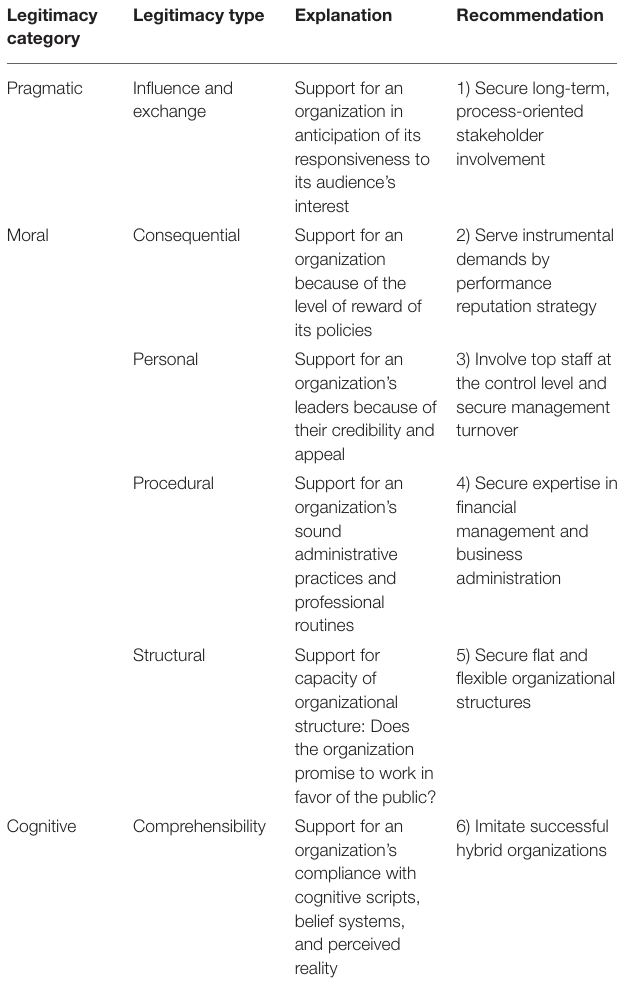
TABLE 1 | Six recommendations for the management of legitimacy building in